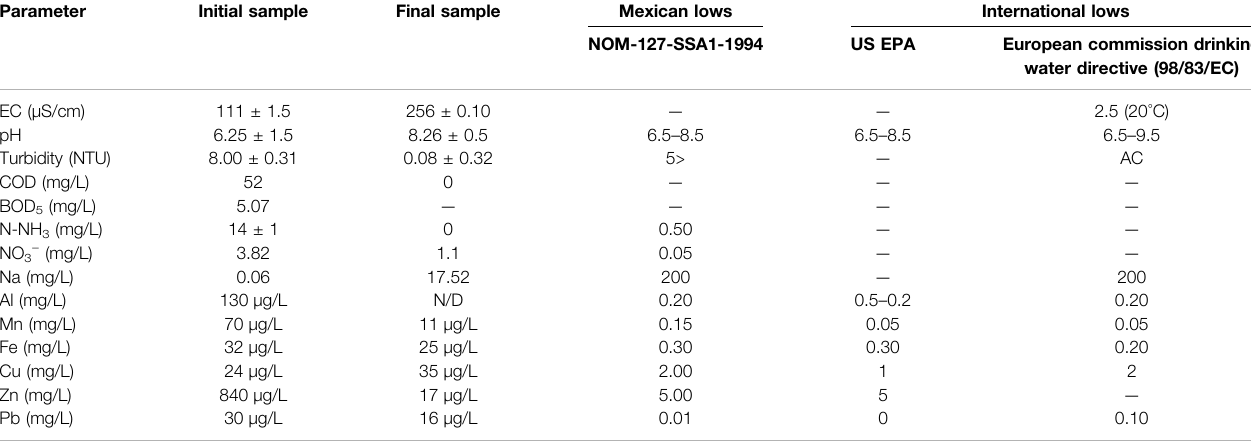
TABLE 4 | Physicochemical characterization: before and after electrochemical treatment. Mexican and international laws for drinking water. Parameter